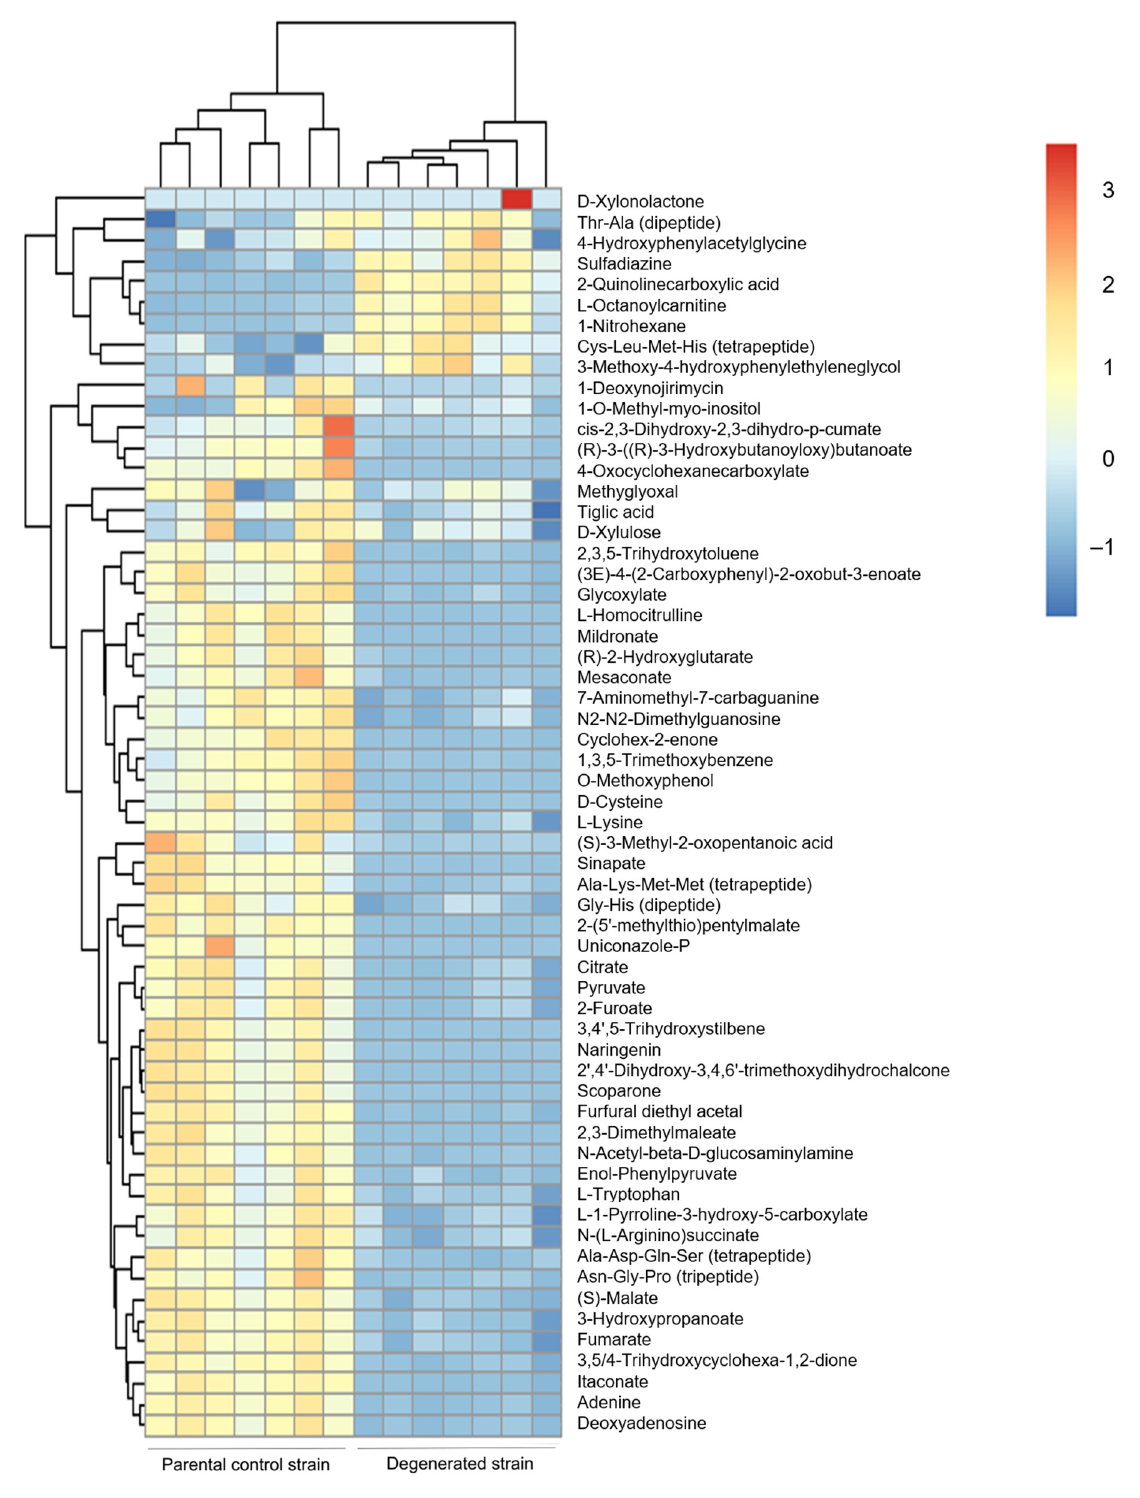
Figure 4. Heatmap representing untargeted LC-MS data from the parental control and degenerated strains for metabolites with significantly different levels. Significantly different metabolites were determined by both t-test with FDR correction and having VIP values >1. This figure was constructed using the heatmap package in R software.